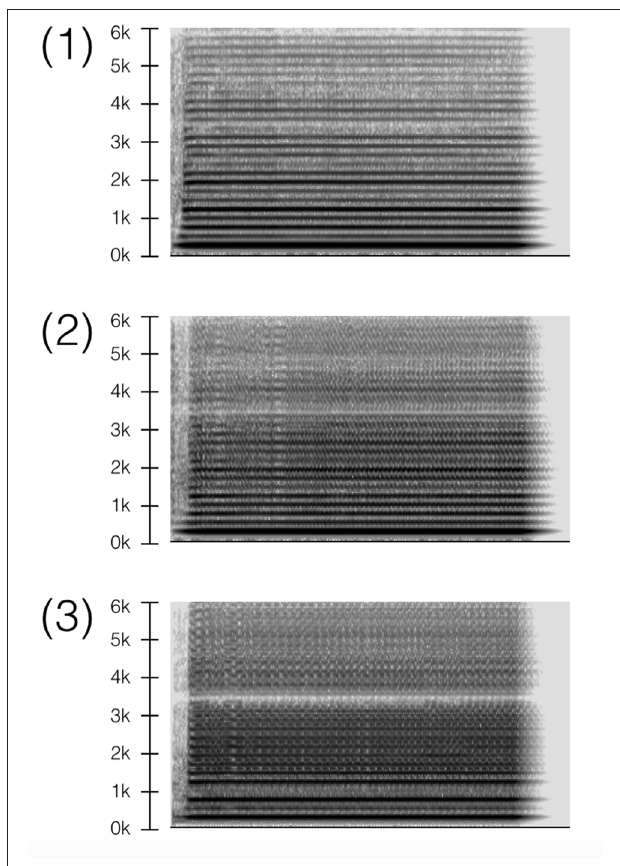
FIGURE 1 | Saxophone stimuli in three conditions: (1) normal, (2) noisy #1, (3) noisy #2. Spectrograph settings : size = 1024 with Hanning window, 50%